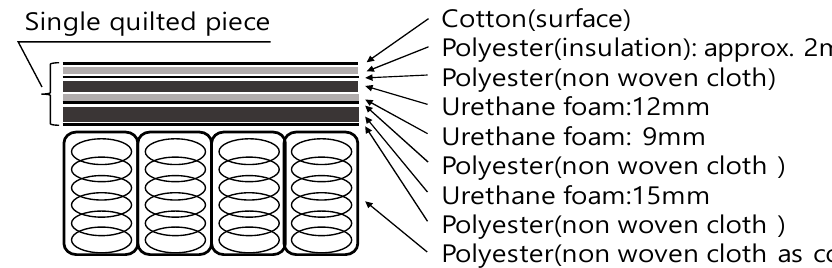
Figure 2. Mattress composition (single side).